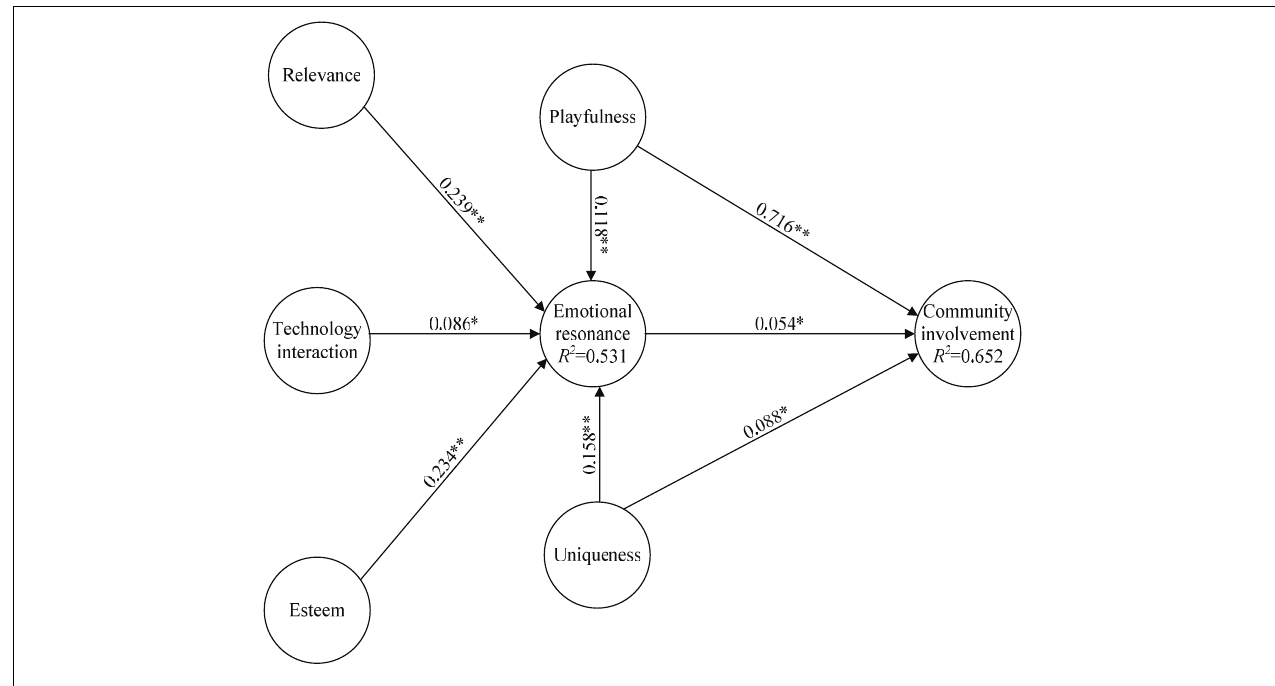
FIGURE 2 | Path coefficients for the research model. ∗ : < 0.05; ∗∗ : <